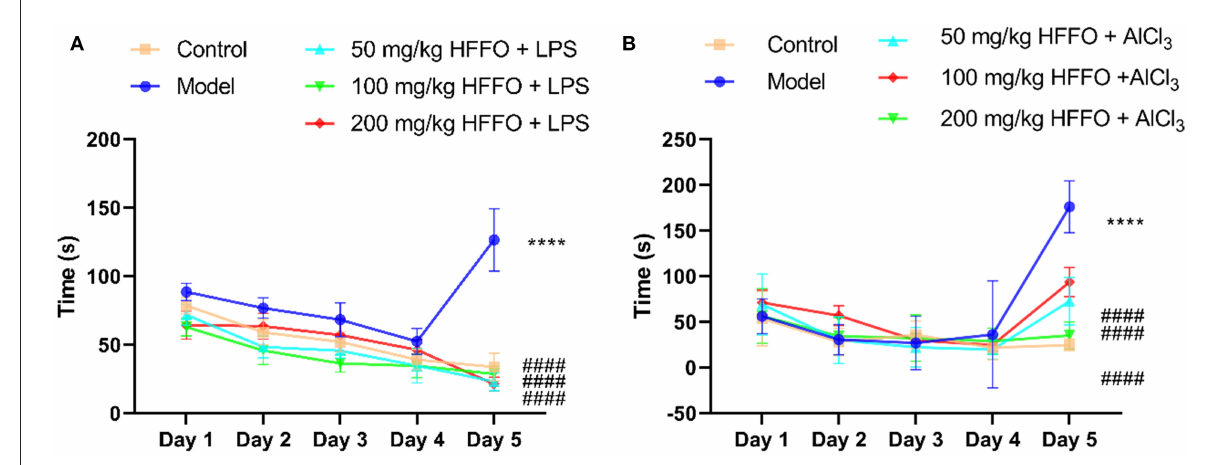
FIGURE1 The latency (s) of first entry into the enriched chamber (EC) zone of the T-maze test. LPS model (A) , AlCl3 model (B) . n = 10, * p < 0.05, ** p < 0.01, *** p < 0.005, **** p < 0.001, vs. the control group; # p < 0.05, ## p < 0.01, ### p < 0.005, #### p < 0.001, vs. the model